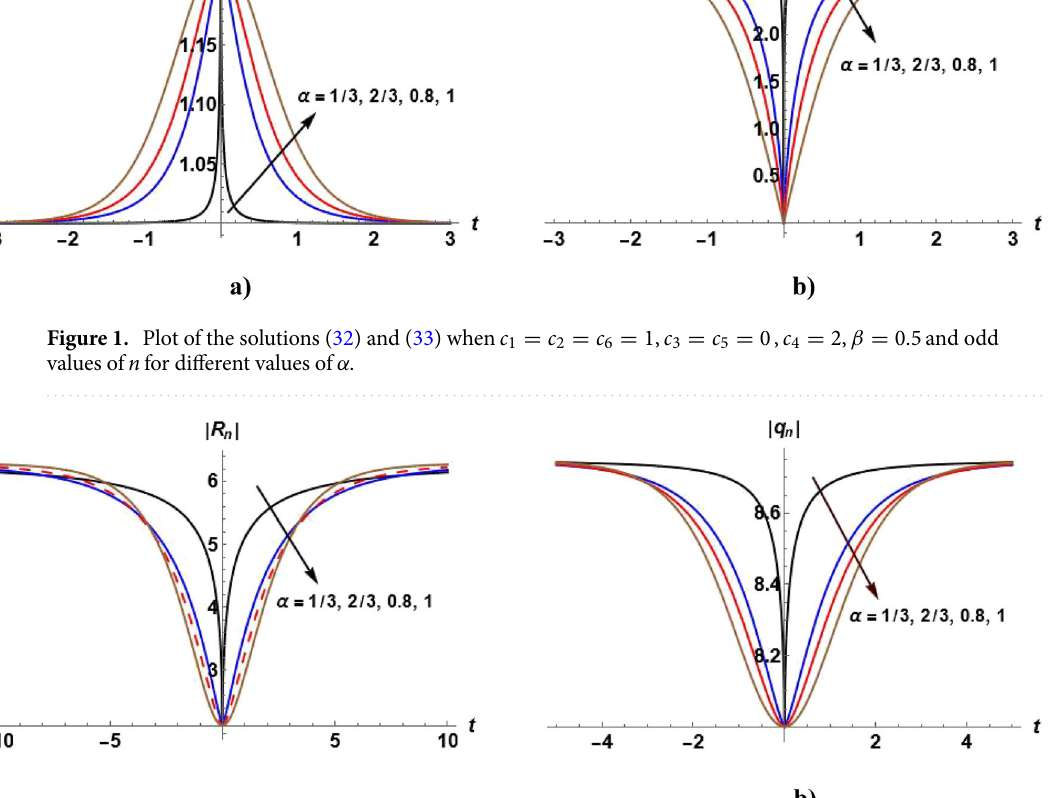
c c 2, c 2 5, c 5 4, c 3 6 = 0 , 4 = β = 0.5 and odd = − = = =